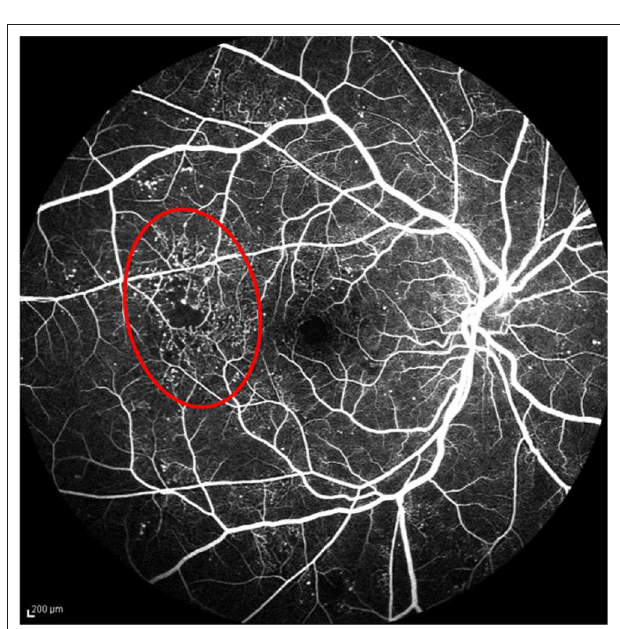
FIGURE 3 | FA image of a subject with diabetes showing significant